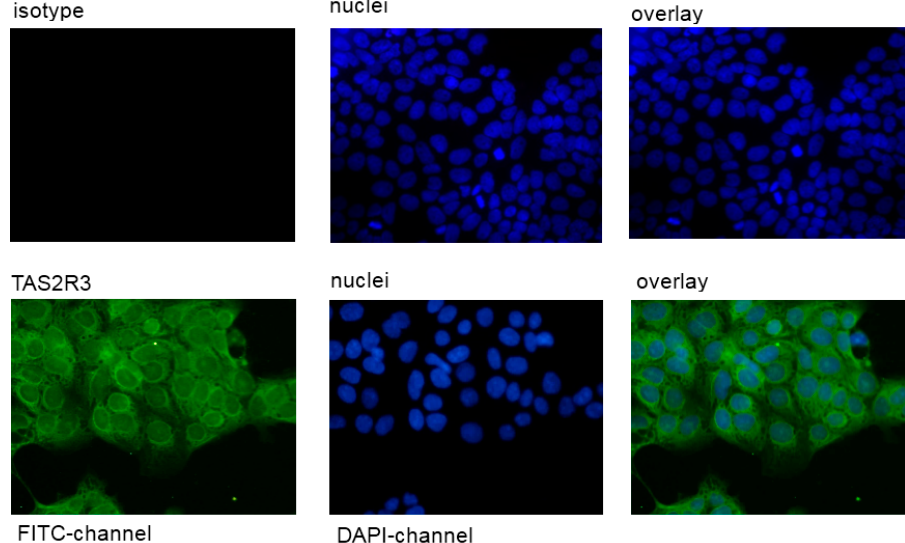
Figure 2. Staining of the human cell line JEG-3 against TAS2R38. The rabbit anti-TAS2R38 antibody was visualized by a secondary FITC-coupled antibody in the FITC channel . The isotype control showed no fluorescence signal in this cell line. The pictures were photographed at magnification of 400×. The bar corresponds to 50 µm.